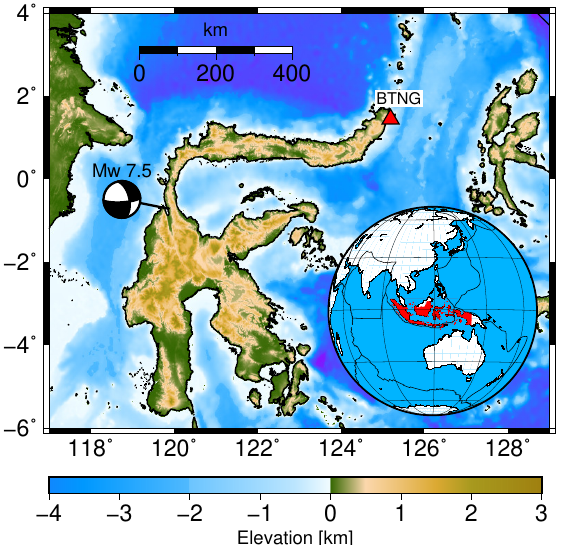
Figure 2. Map of the Sulawesi region and the GNSS receiver used in this study. Receiver BTNG (Bitung, Indonesia) is the only station within 600 km of the epicenter that has open-access data. The beach ball describes the earthquake moment tensor, which indicates dip-slip motion along this fault. Inset shows Indonesia in red, centered on the Sulawesi M w 7.5 epicenter.